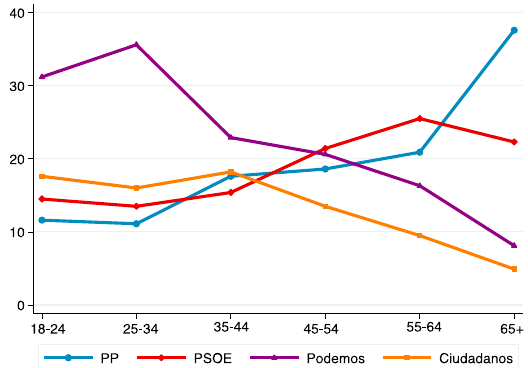
Figure 3. Vote for the four main parties in the 2015 General Election by age group. Source: Centre for Sociological Research, Postelection Surveys (2015 General Election).